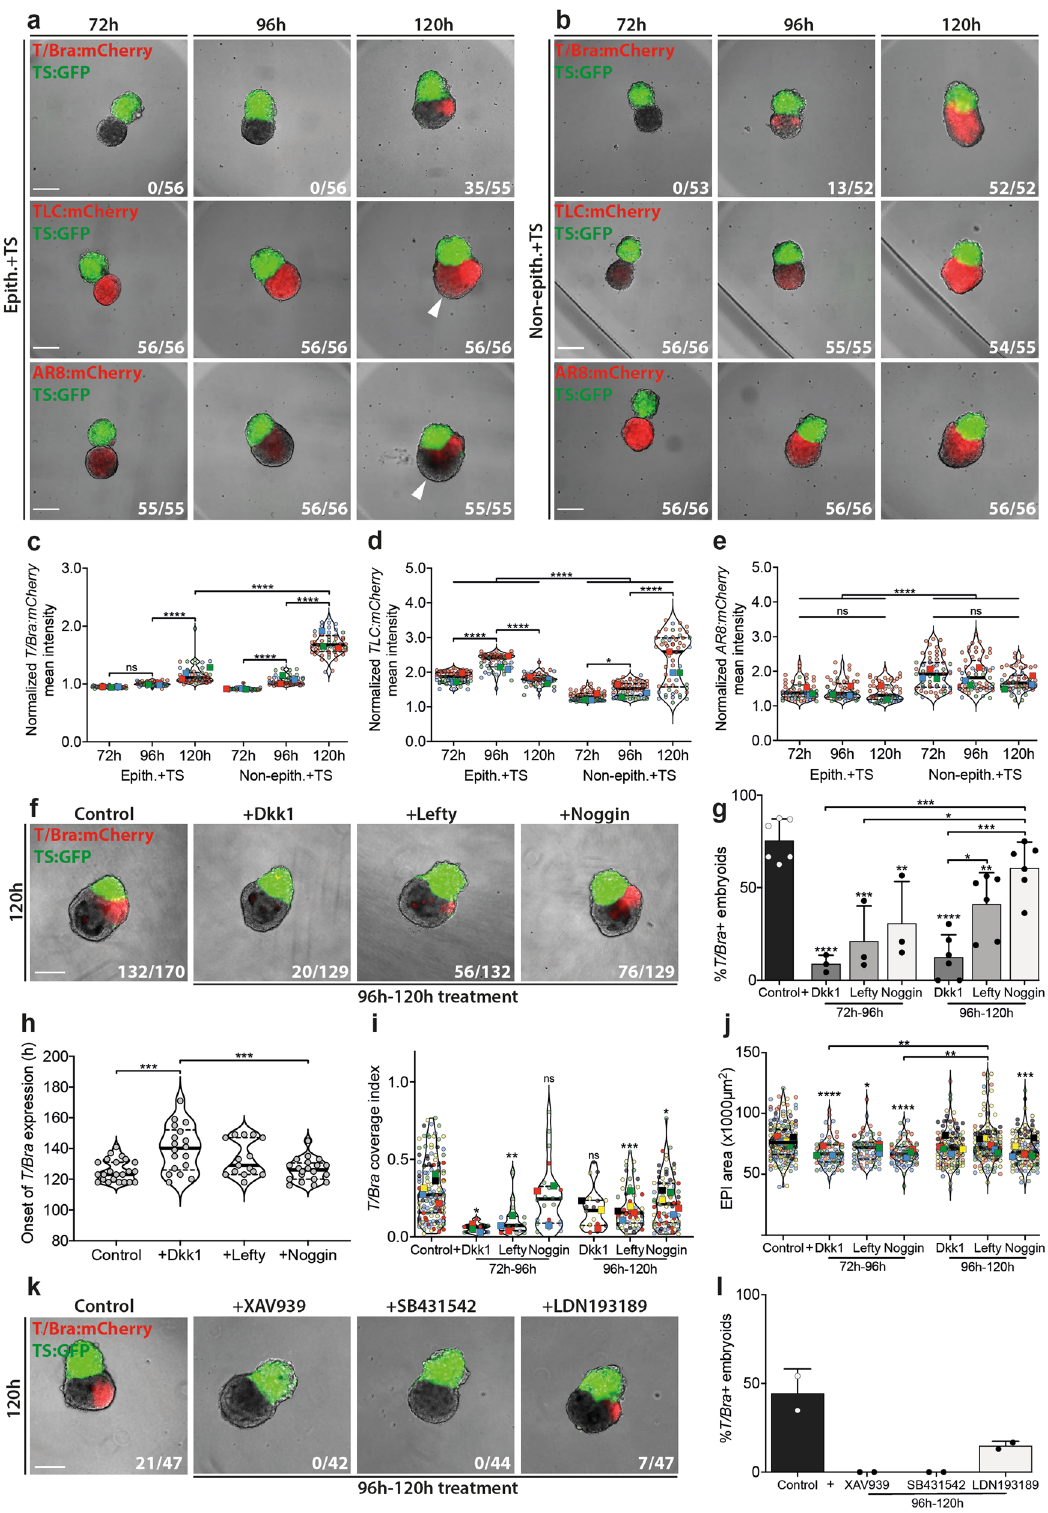
accompanied by elevated WNT and TGF- β activity by 120 h, resembling an expanded posterior domain observed in Dkk1 − / − and Cer1 − / − ;Lefty1 − / − mutant embryos 38,39 . To test whether gastrulation-like processes observed in epithelialized EpiTS embryoids involve mechanisms similar to those observed in the embryo, we inhibited the above pathways by adding Dkk1 (i.e., a WNT inhibitor), Lefty (TGF- β inhibitor), and